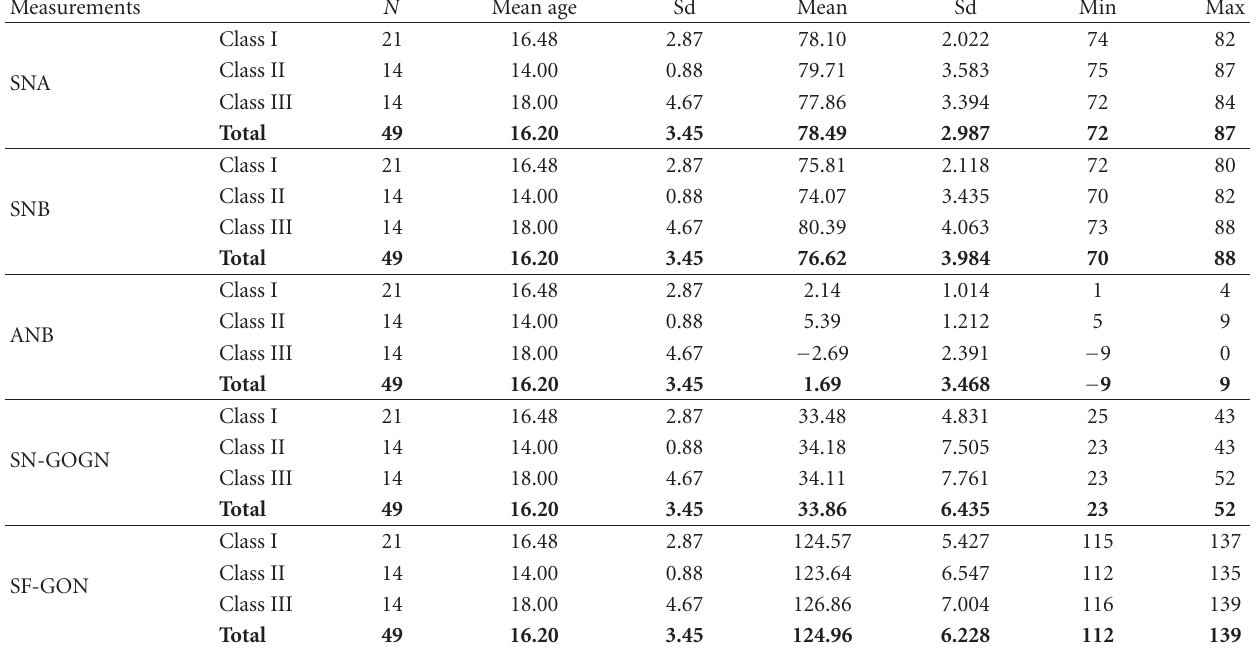
Table 1: Maximum, minimum, least square means, and standard deviation of the means for patients. Measurements